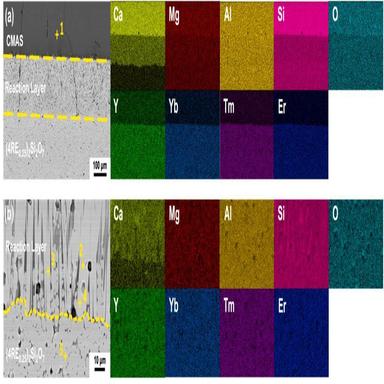
Cross-sectional SEM images and corresponding elemental mappings of (Y0,25Er0,25Tm0,25Yb0,25)2Si2O7 after CMAS corrosion at 1300 ◦C for 12 h under (a) low magnification and (b) high magnification.